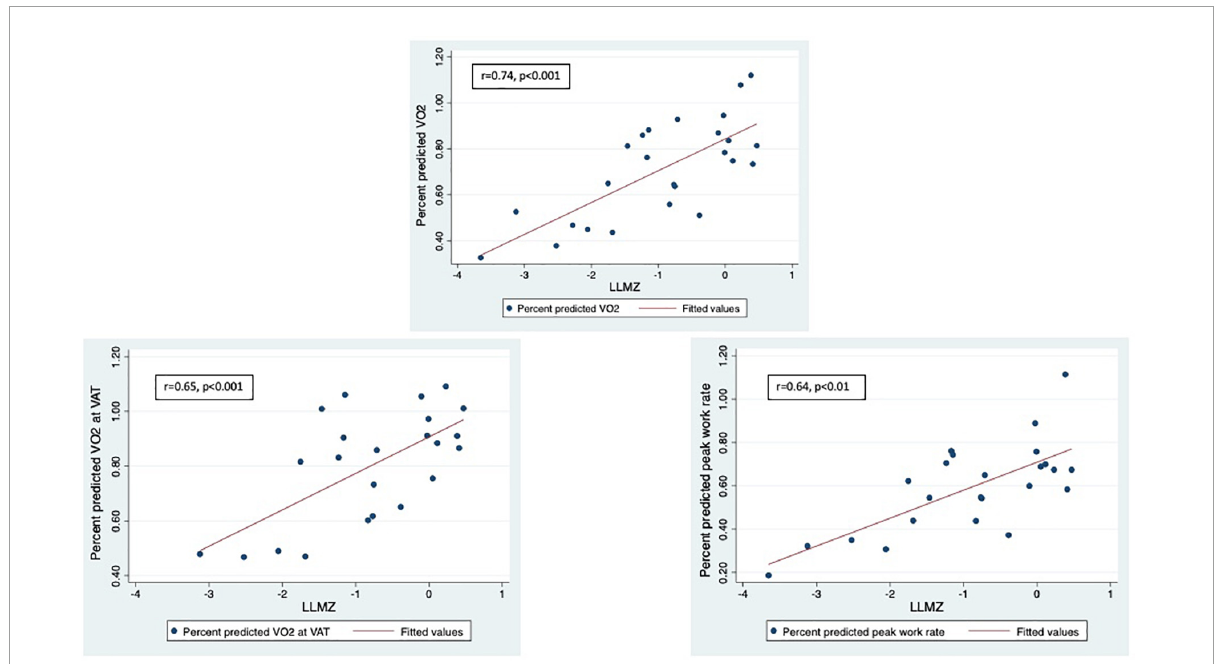
FIGURE1 LLMZ, D-HGZ, and PAQ score were associated with percent predicted peak VO 2 , percent predicted VO 2 at VAT, and percent predicted work. This figure demonstrates the associations between LLMZ and CPET